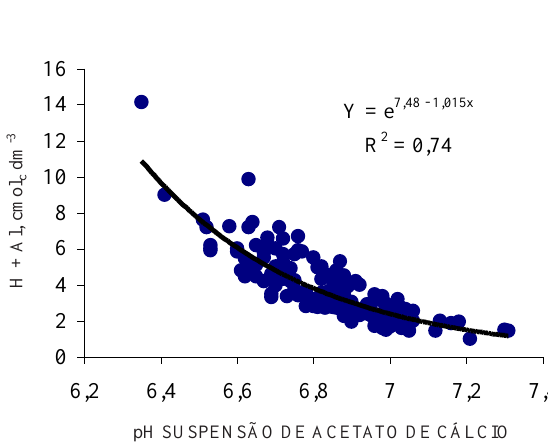
Figura 2. Relação entre H + Al e pH da suspensão de acetato de cálcio.